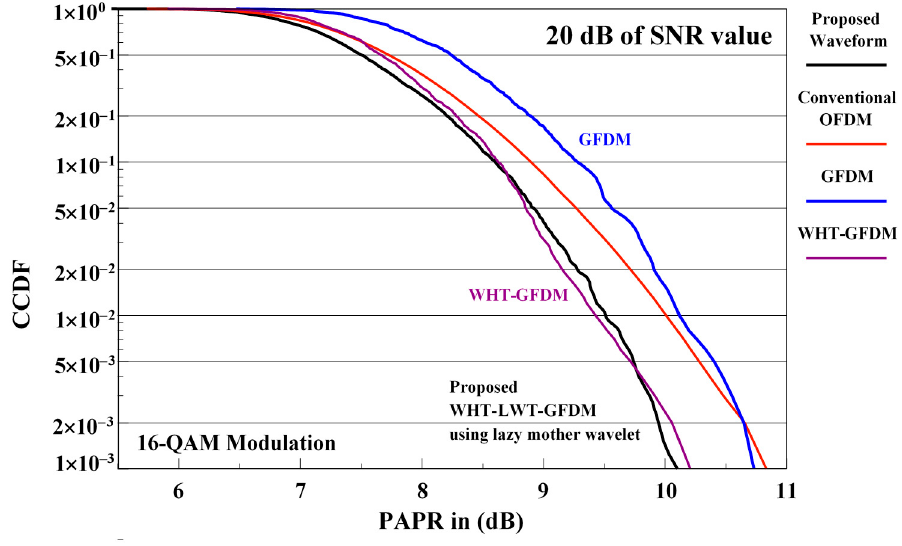
Figure 15. The PAPR performance comparisons of the conventional OFDM, GFDM, WHT-GFDM, and WHT-LWT-GFDM waveforms for a SNR value of 20 dB for 16-QAM modulation.